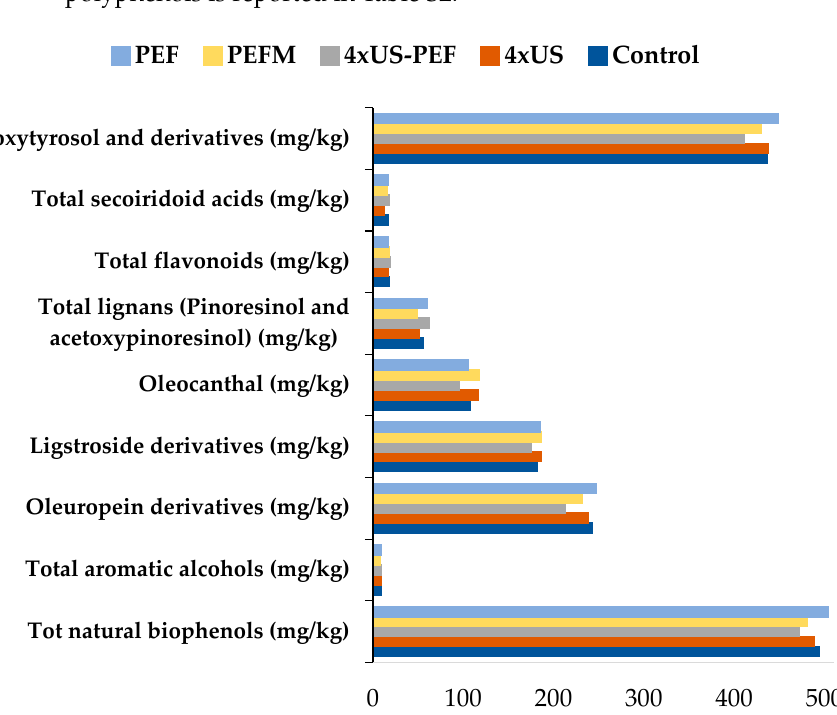
Figure 9. Total biophenols and their composition of Coratina oil samples according to processing technology.